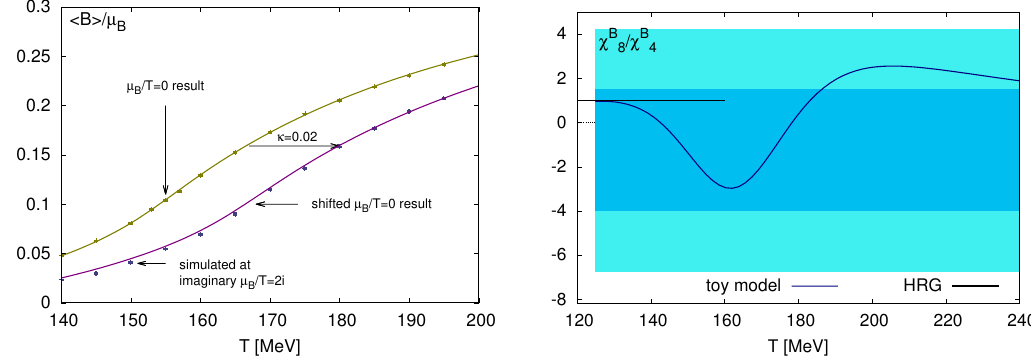
Figure 2 . Toy model setup and its result for (cid:31) B =(cid:31) B . In the left panel we observe that the directly 8 4 simulated (cid:31) B ( T; ^ (cid:22) B ) =(cid:22) B at imaginary chemical potential can be approximately reproduced by 1 rescaling the (cid:22) B = 0 result (cid:31) B ( T; 0), (see eq. (3.2)). The right panel shows a speci(cid:12)c ratio of high 2 order (cid:13)uctuations. The extraction of (cid:31) B is stabilized by a prior bound to (cid:31) B . With dark and light 8 4 bands we show the one and two (cid:27) regions of the prior distribution. The Hadron Resonance Gas predicts 1 for this ratio, at high temperatures the Stefan-Boltzmann limit gives zero.